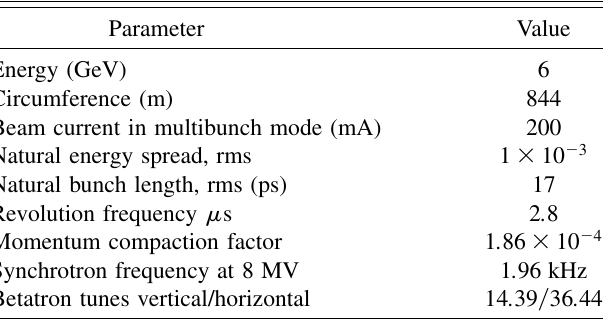
TABLE I. ESRF machine